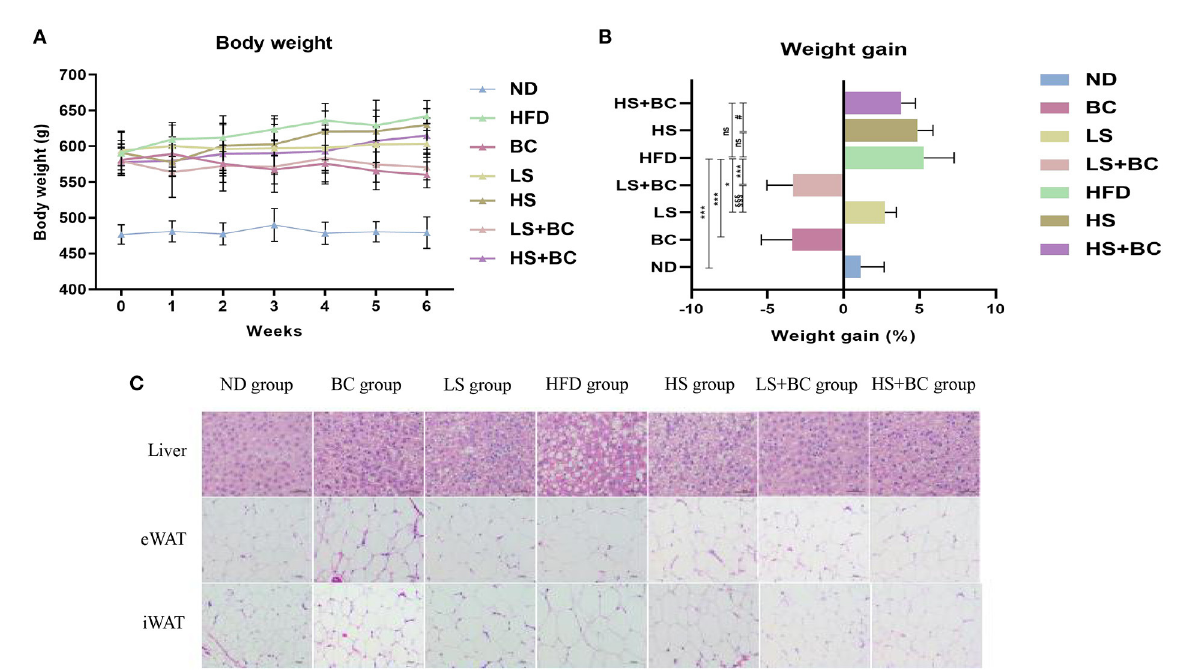
FIGURE1 Effect of BCPs treatment on body weight and liver steatosis in HFD-induced obese rats. (A) body weight (g), (B) weight gain (%), (C) histological analysis for liver and adipose tissues. Values are means ± SEMs. * p < 0.05, ** p < 0.01 and *** p < 0.001 when comparing other groups with HFD